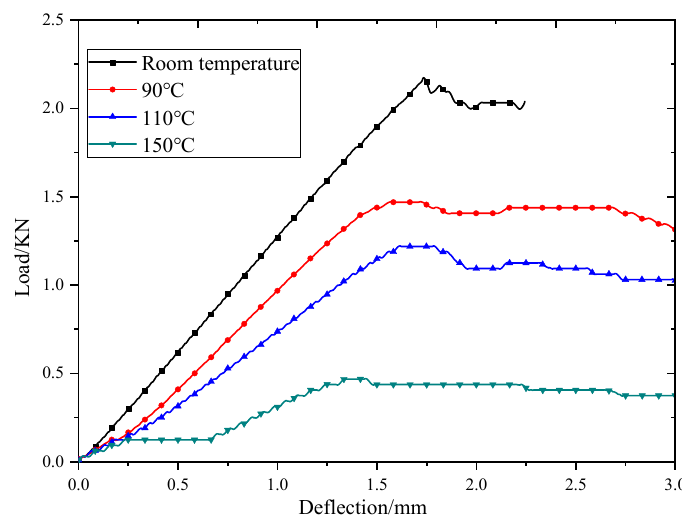
Figure 5. Bending deflection–load curves of 3Dim–5Dir braided composite specimens at different Figure5. Bendingdeflection–loadcurvesof3Dim–5Dirbraidedcompositespecimensatdifferenttemperatures.